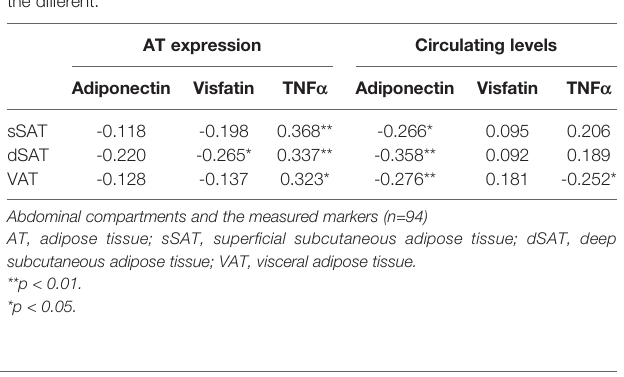
TABLE 2 | Correlations (Spearmans rho) between the amount of AT in the